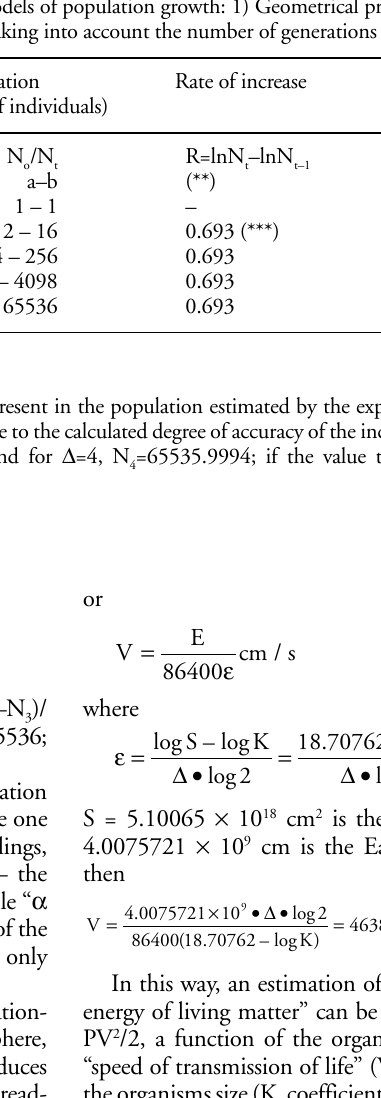
Table 3. Multiplication of living beings, according two models of population growth: 1) Geometrical progression of ratio Q=2, N